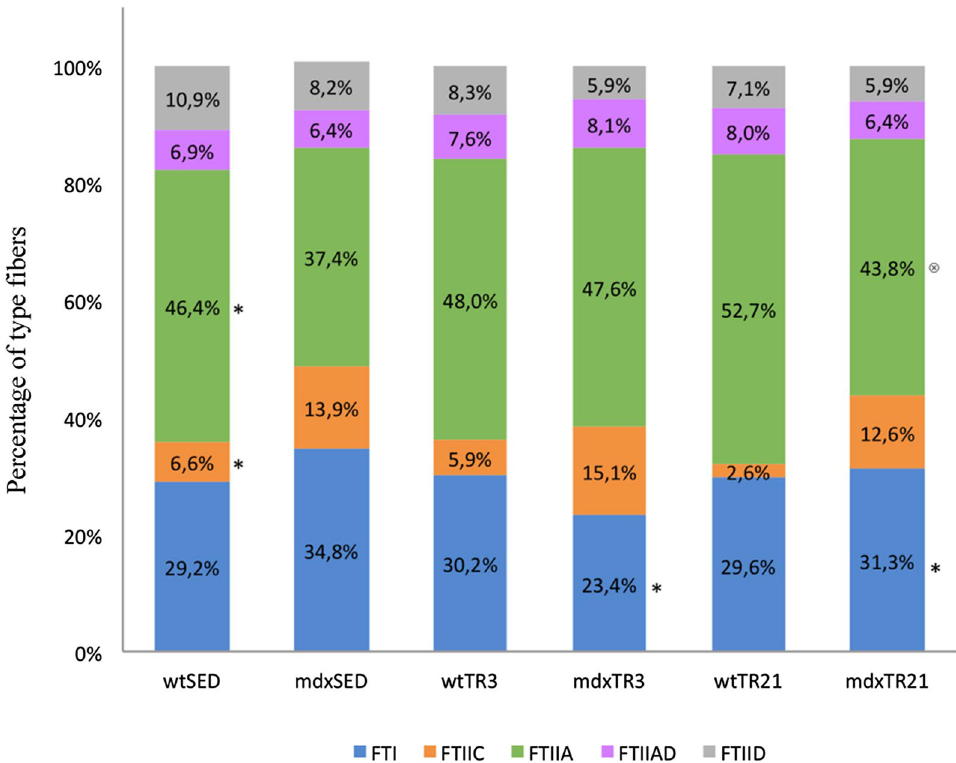
Figure 4. Percentage measurement of type I, IIC, IIA, IIAD and IID of muscle fibers in all groups studied. * p < 0,05 compared to mdx SED, ⊗ p < 0.05 compared to mdx TR 3. Abbreviations: wild-type Sedentary group ( wt SED); mdx Sedentary group ( mdx SED); wild-type Training group for 3 days ( wt TR 3 ); mdx Training group for 3 days ( mdx TR 3 ); wild-type Training group for 21 days ( wt TR 21 ); and mdx Training group for 21 days ( mdx TR 21